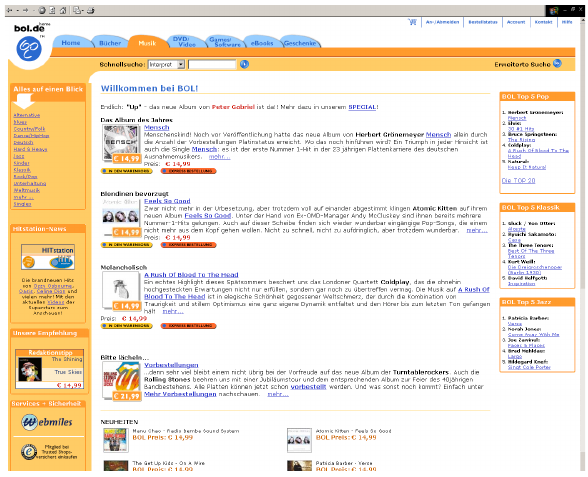
Figure 1: Screen shot of one web page. All web pages were similar in the depicted structure, but differed in the products being